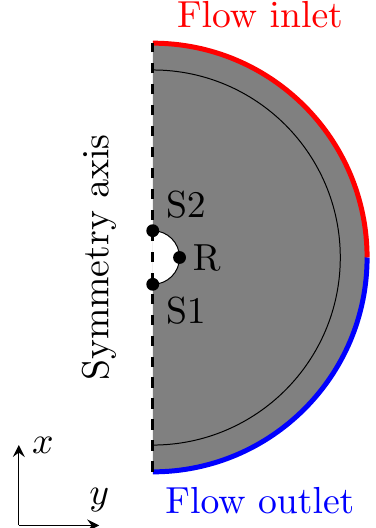
Figure 3. Schematic geometry of the simulation. In the model, upwind and downwind scenario is modelled by moving the the source position between S1 (upwind) and S2 (downwind). The outermost layer of the circular domain is defined as PML for the acoustic